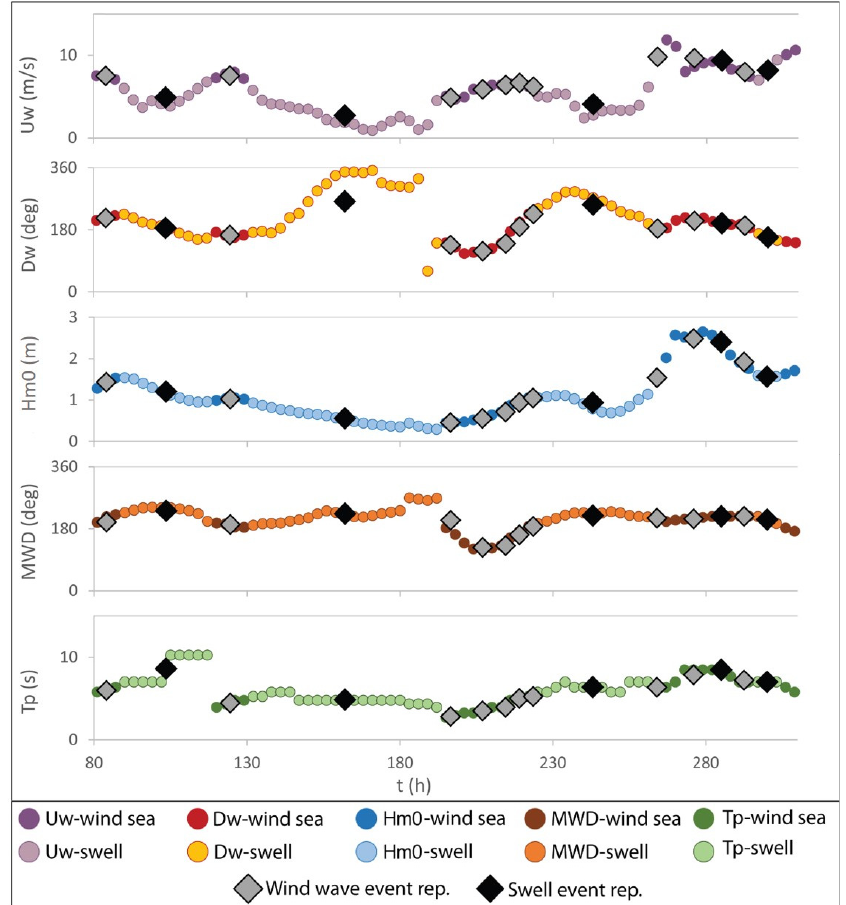
Figure 15. Wind velocity (Uw), wind direction (Dw), significant wave height (Hm0), mean wave direction (MWD), spectral peak wave period (Tp), and representative characteristics of wave scenarios covering a subset of time period (5_sf) of salient formation for swell and wind seas, extracted from the methodology applied.